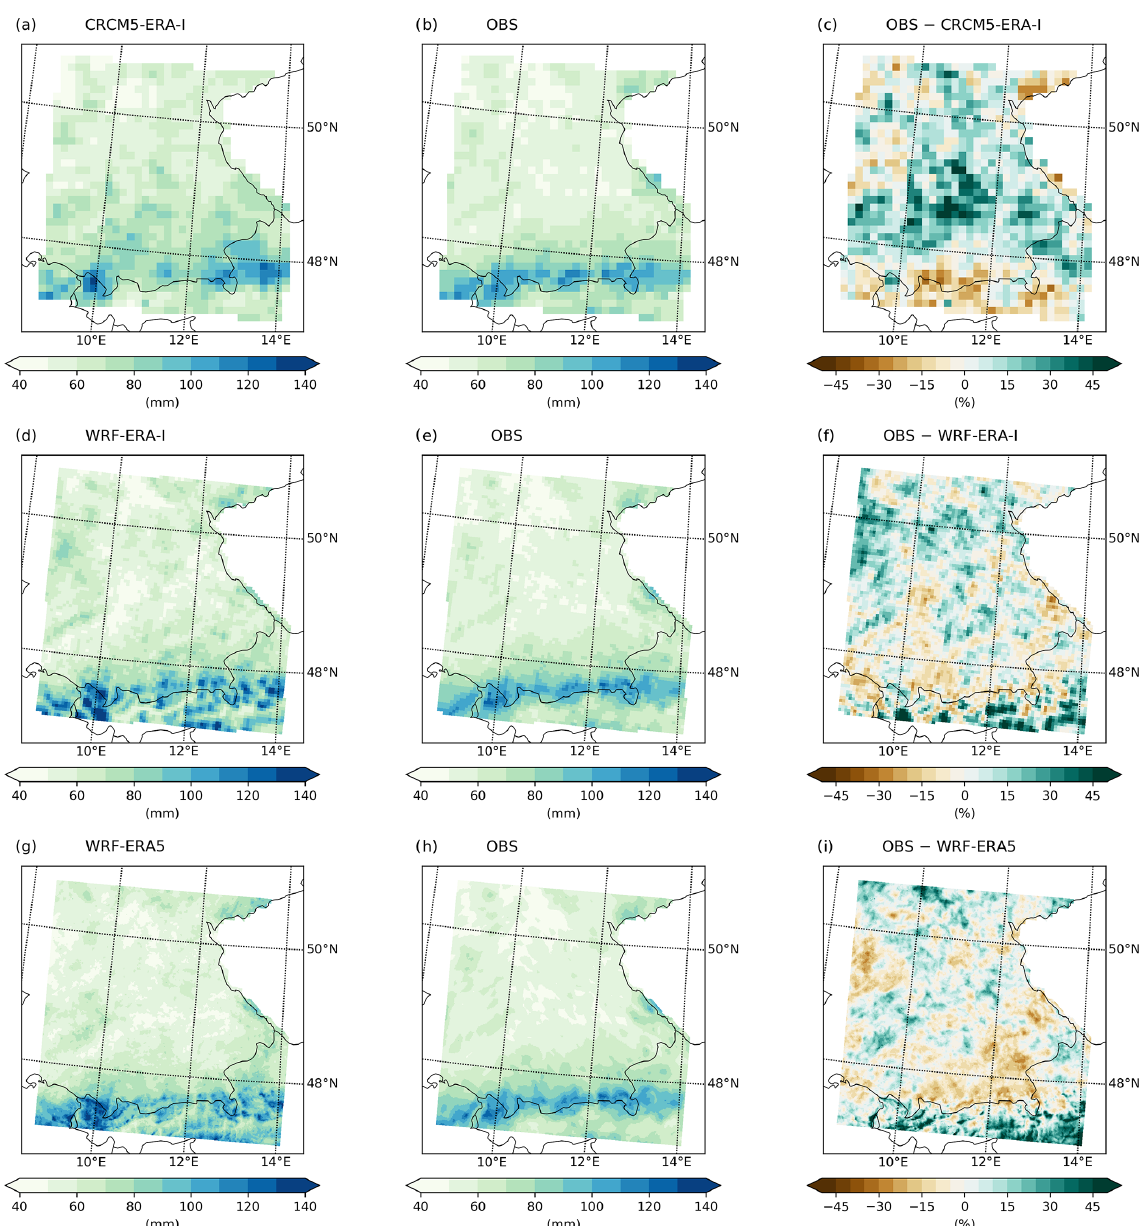
Figure 4. The 10-year rainfall return levels applying GEV-LMOM based on CRCM5 ERA-Interim (a) , WRF ERA-Interim (d) , and WRF ERA5 (g) . The middle column (b, e, h) shows the observational product bilinearly interpolated to the respective climate model grid. The right column (c, f, i) provides the percentage difference calculated as the climate model return level minus the observational return